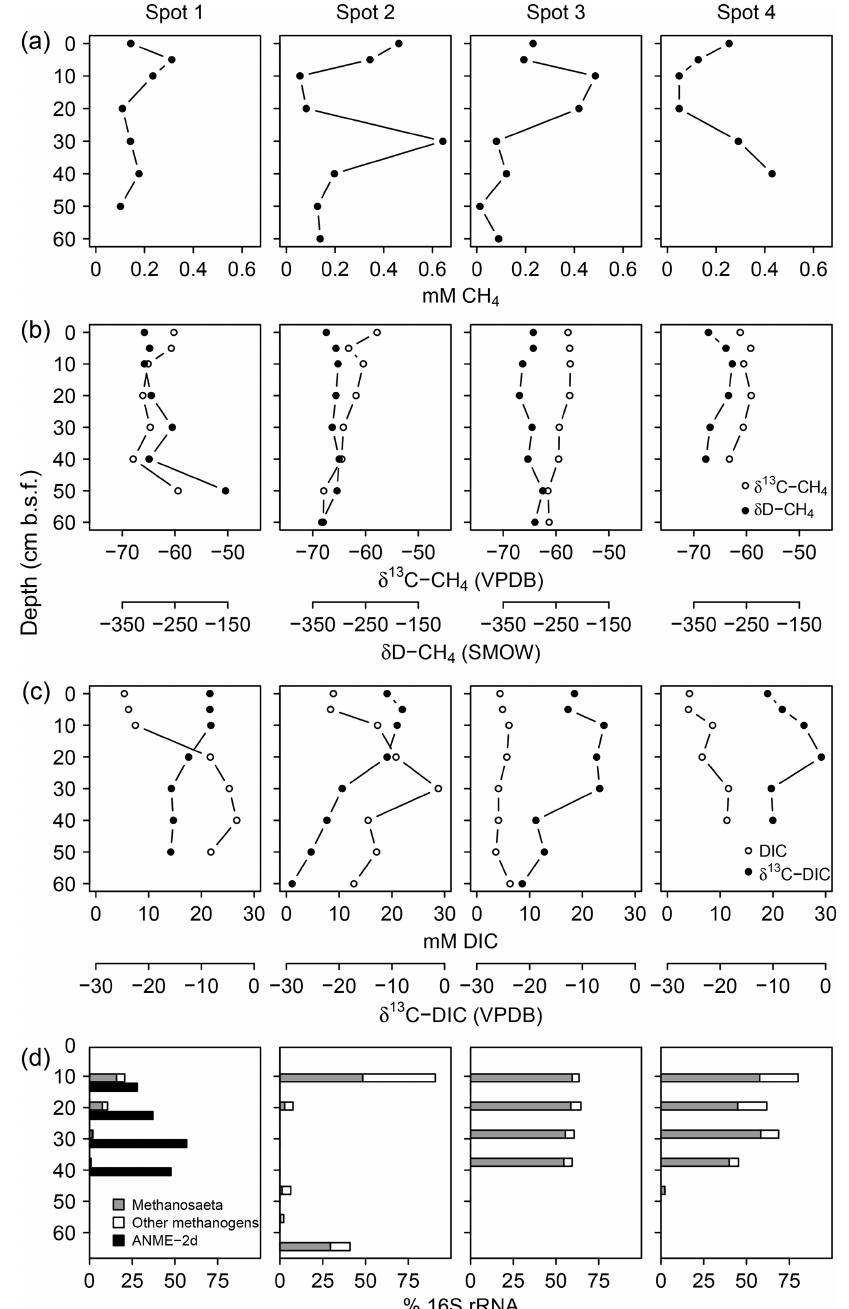
Figure 7. Concentration patterns and isotope ratios for CH 4 (a, b) and DIC (c) , as well as average relative abundances of methanogens and methanotrophs (d)